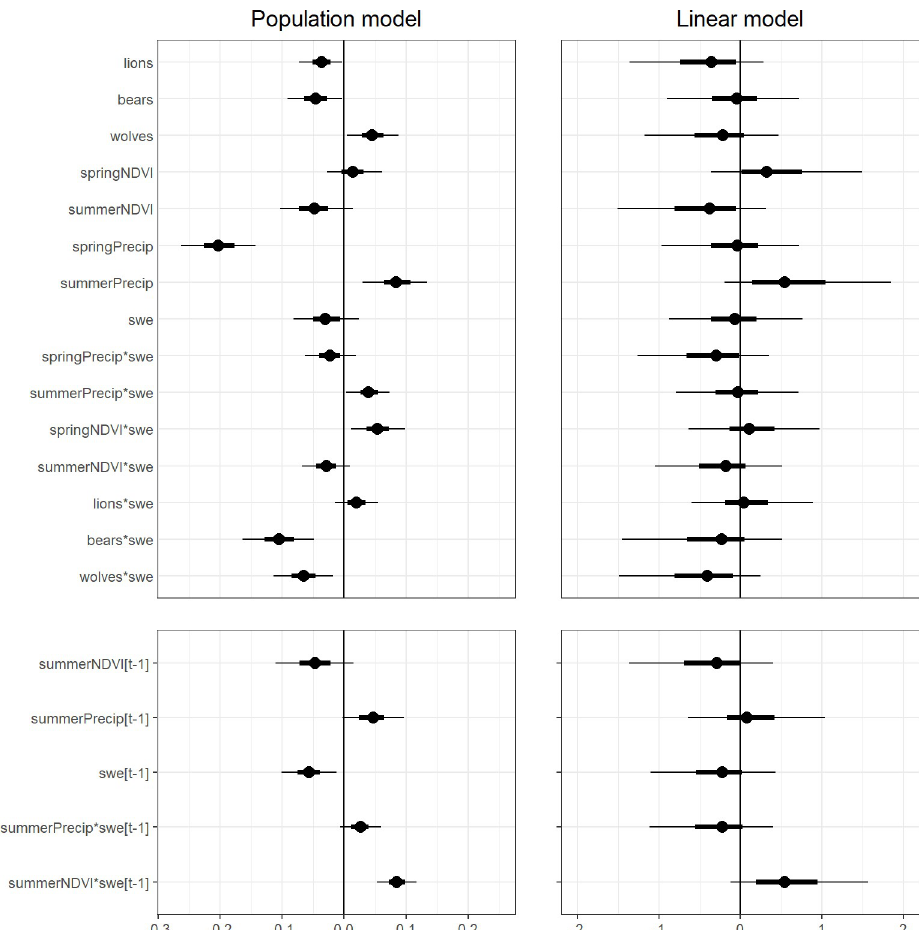
Fig 4. Estimated regression coefficients for standardized covariates. The black dot denotes the median of the approximate posterior distribution, the heavy black line the 50% highest posterior density interval (HPD) and the light black line the 90% HPD interval. The left panel is for the population model, where regression coefficients apply to the per capita recruitment rate and use the logit link. The right panel is for the age ratio model that uses the identity link. The vertical line (0) corresponds to no association with a